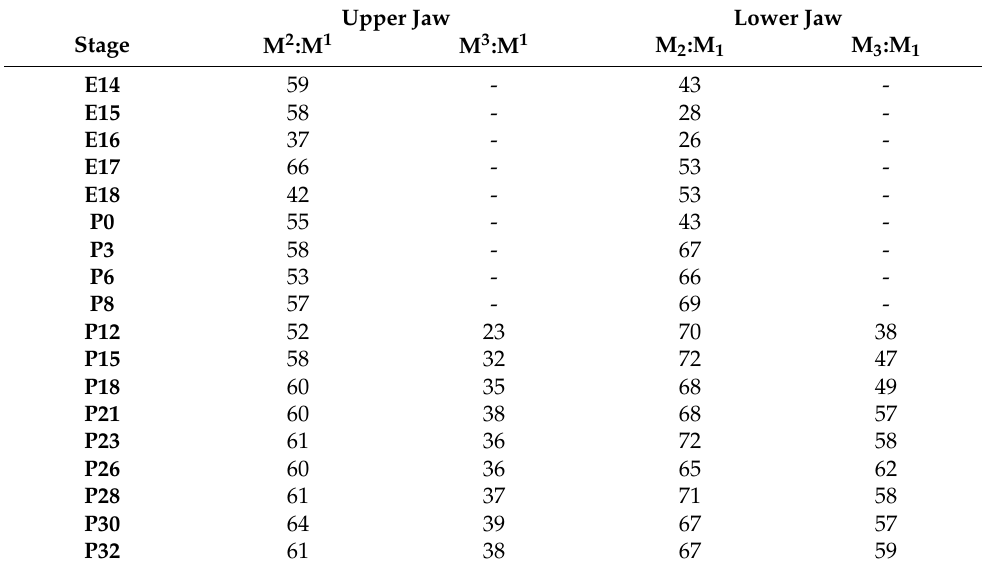
Table 5. Ratios of averaged first (M1), second (M2) and third (M3) molar mesiodistal lengths from stages/ages E14 to P32, for left and right sides of each jaw type (upper; lower). The closer a value is to 100, the greater the parity of M2 or M3 length relative to M1. Ratios tend to increase with stage because, relative to M1 (which is crown complete by P8), the M2 and M3 elongate until about P12 and P21, respectively. We saw a trend of smaller M2:M1 ratios in the lower jaw until about birth (P0), after which M2:M1 ratio was smaller in the upper jaw. Conversely, M3:M1 ratios were consistently smaller in the upper jaw. “-” = a molar was not yet forming and could not be measured thus the ratio is absent for that stage/age